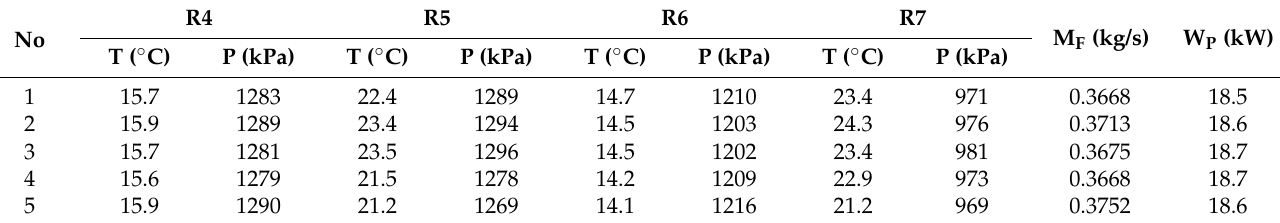
Table 14. Refrigerant side measurement result (five